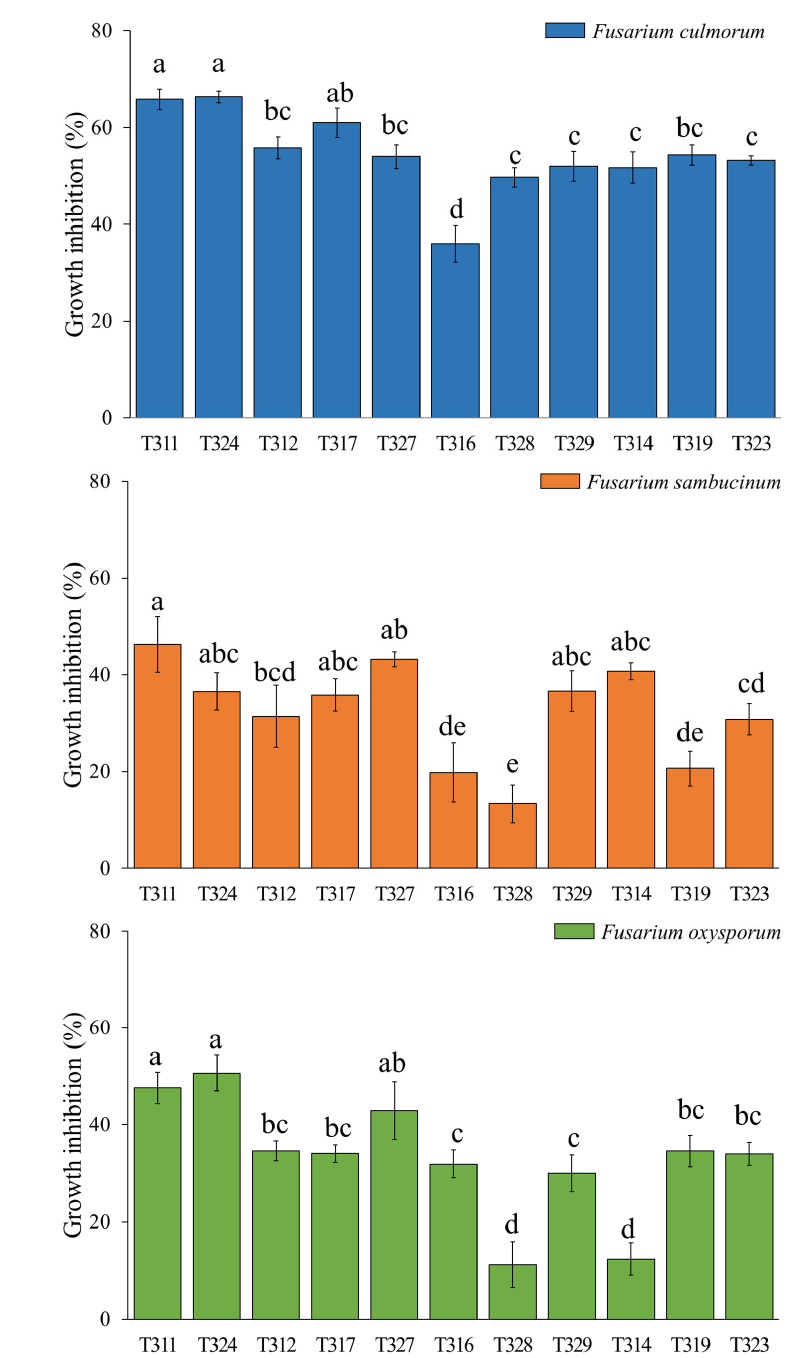
Figure 3. Growth inhibition percentages of the Trichoderma isolates against ( a ) F. culmorum , ( b ) F. sambucinum , and ( c ) F. oxysporum in vitro by direct confrontation. Mean values ± SE. Columns within the same chart with different letters indicate significant differences (Fisher’s LSD p < 0.05). The isolates of T. spirale (T314 and T319) showed significantly similar inhibition per- centages for F. culmorum (51.7% and 54.3%) but interacted differently against the other Fusarium species. T. spirale T314 had high inhibition percentages against F. sambucinum (40.7%) without significant differences with T. hamatum (T311 and T324), and T. spirale T319 showed a higher inhibition percentage against F. oxysporum (34.6%) without